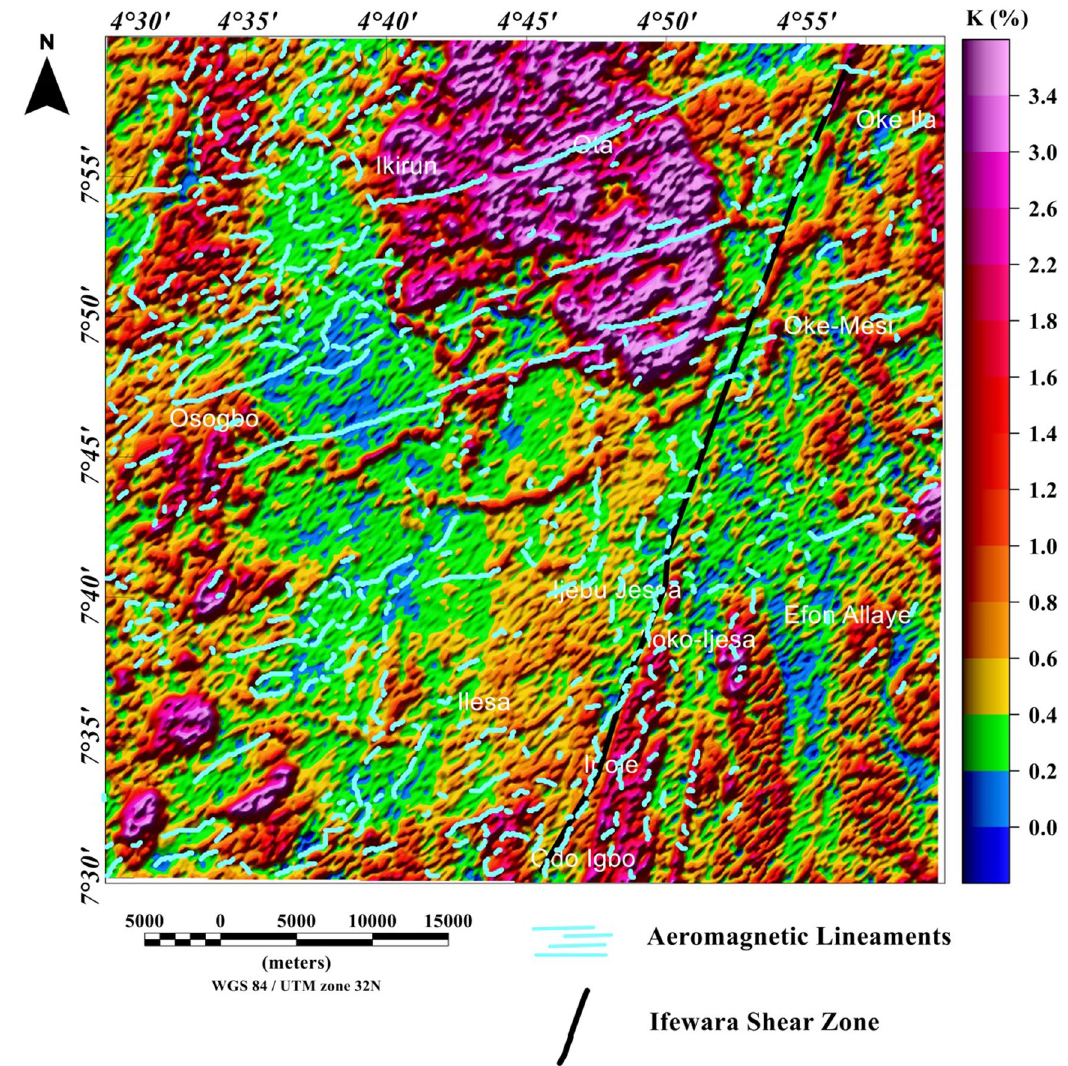
Figure 13. Map of potassium (%) data of the Ife-Ilesha schist belt with superimposed Ifewara shear zone extracted from the total gradient amplitude map presented in color-shaded relief, illuminated from the north- northwest direction. The north-northwest illumination (azimuth: 337.5 degrees and light angle: 45 degrees) enhances north-northeast lineaments. The figure was produced using Oasis Montaj Software version 8.3.3 (Website: https:// www. seequ ent.